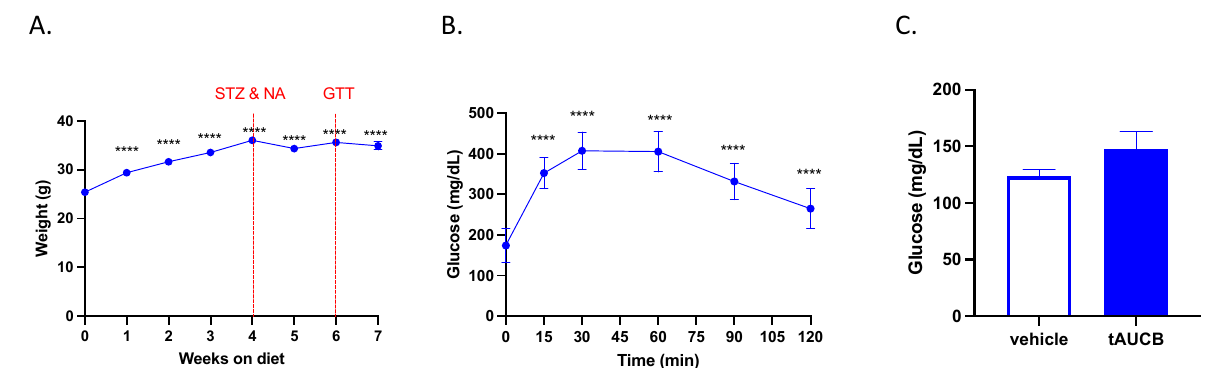
Figure 3. tAUCB does not alter blood glucose concentration in diabetic mice. Mice on high-fat diet injected with NA and STZ develop a diabetic phenotype: ( A ) Mice were placed on a high-fat diet for 7 weeks, and injected with NA and STZ (indicated by first vertical red line) to induce type 2 diabetes, body weight increased following 1 week on high-fat diet, and persisted throughout ( p < 0.0001 vs. week 0, n = 16). ( B ) After 6 weeks on high-fat diet (indicated by second vertical red line), and 2 weeks following NA and STZ injections, glucose tolerance testing revealed hyperglycemia at baseline (time 0), and impaired glucose clearance with blood glucose concentration remaining elevated 2 h after ingestion of 2 g/kg glucose (**** p < 0.0001 vs. time 0, n = 16). ( C ) Blood glucose concentration measured 24 h following tAUCB administration and MCAO show no difference between tAUCB and vehicle groups in DM2 mice ( n / s , n = 8/group).